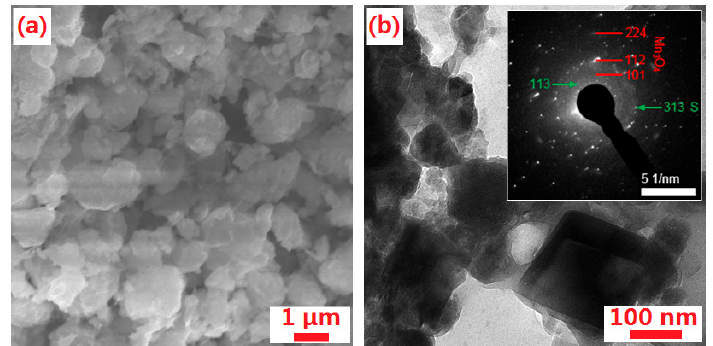
Figure 4. ( a ) SEM image and ( b ) high magnification TEM image and corresponding SAED patterns (inset) of S/Mn 3 O 4 .